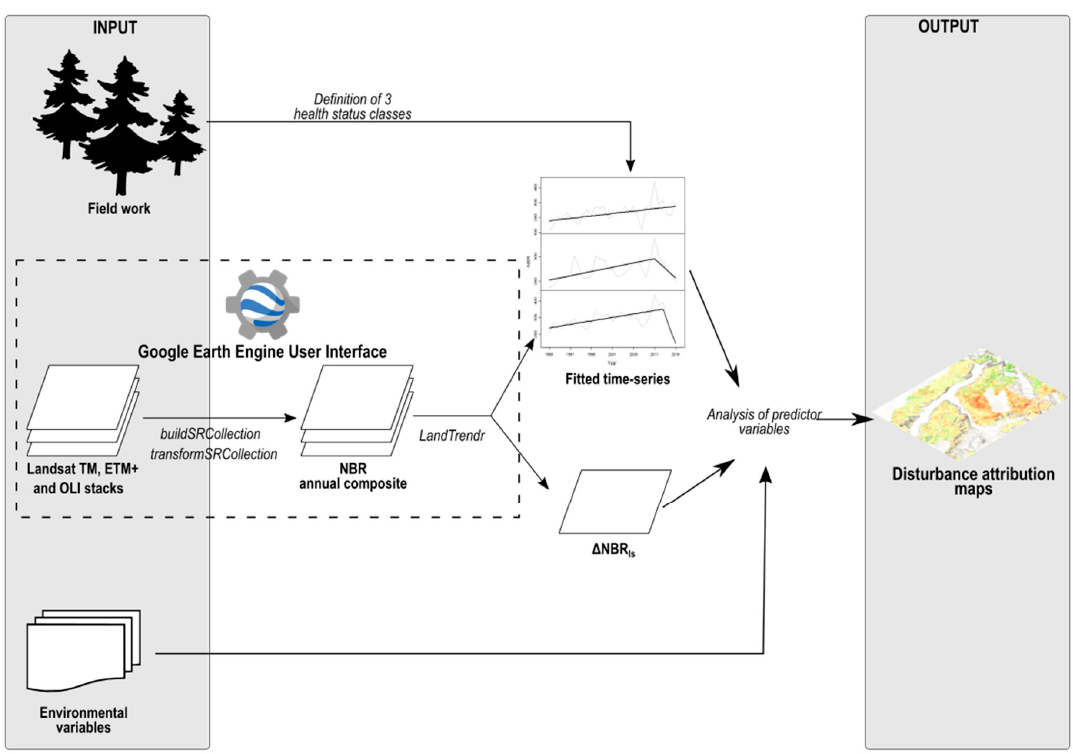
Figure 1. Flowchart describing the methodological steps of Landsat image collection and processing to describe ‘Candidatus Phytoplasma pini’ defoliation levels for the southeastern Andalusia Pinus halepensis forests utilizing the Google Earth engine .